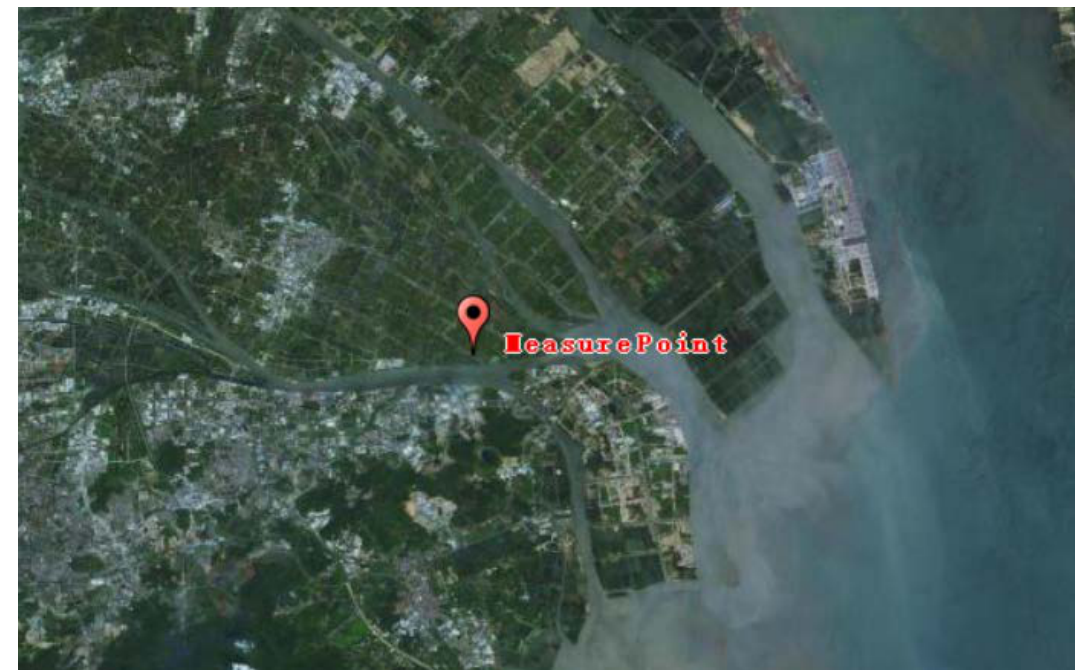
Figure 1. Location of measuring point.